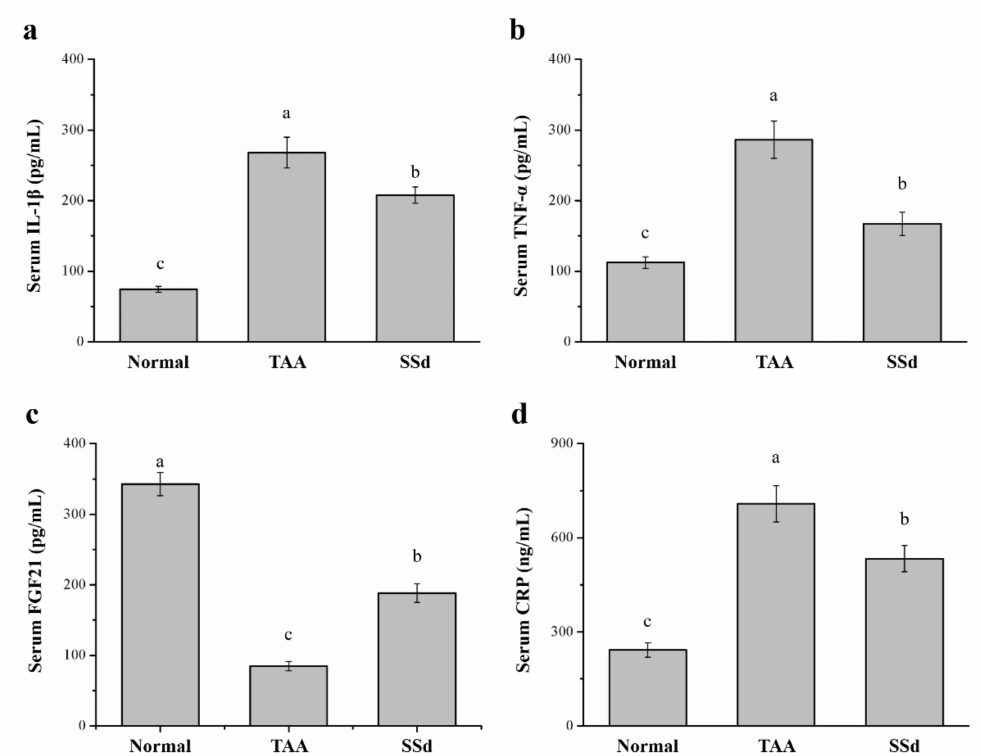
Figure 4. Changes in serum ( a ) IL-1 β , ( b ) TNF- α , ( c ) FGF21, and ( d ) CRP levels in the control, TAA, and SSd groups over 8 weeks. All data are reported as means ± SD (n = 8). a–c Data with different letters above the columns were significantly different on one-way ANOVA, and Duncan’s test at p < 0.05 was used to compare the means of the three groups. IL-1 β , interleukin 1 beta; TNF- α , tumor necrosis factor alpha; FGF21, fibroblast growth factor-21; CRP, C-reactive